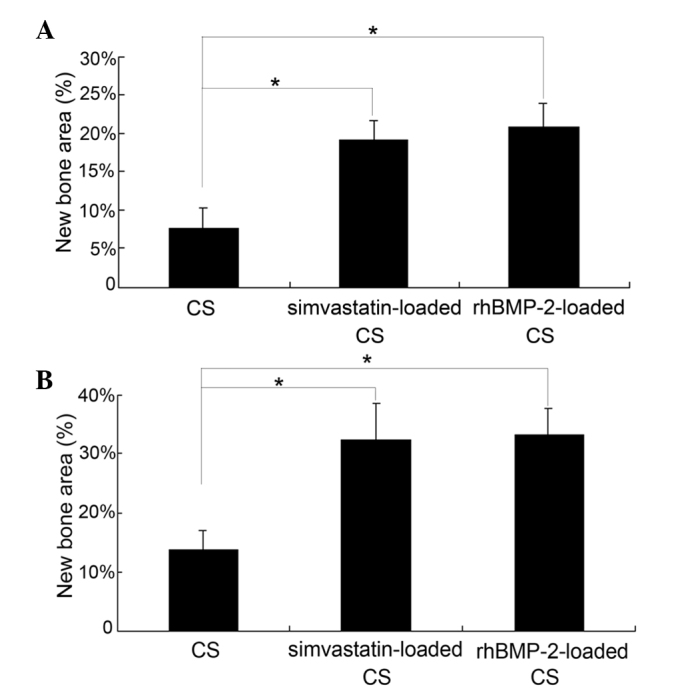
Comparison of the area of newly formed bone tissue in the defect area of three groups at (A) 4 and (B) 8 weeks following implantation. Results are expressed as mean ± standard deviation. *P<0.05, vs. CS. CS, calcium sulphate; rhBMP-2, recombinant human bone morphogenetic protein 2.